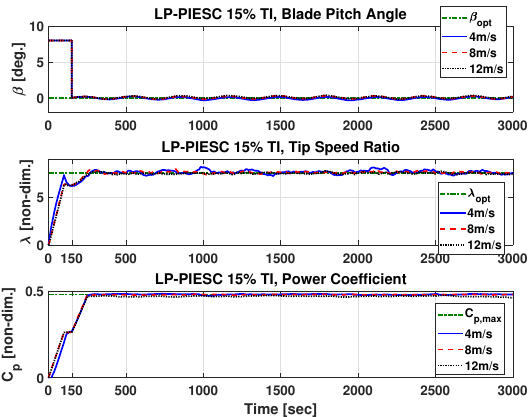
Figure 26. Performance of LP-PIESC with the parameters shown in Table 6 and wind input with 15% TI. Blade pitch angle β ( top ), tip speed ratio λ ( middle ), estimated power coefficient C p ( bottom ). The dashed horizontal lines indicate optimal parameters β opt , λ opt and C P ,max . The LP-PIESC is turned on at 150 s.